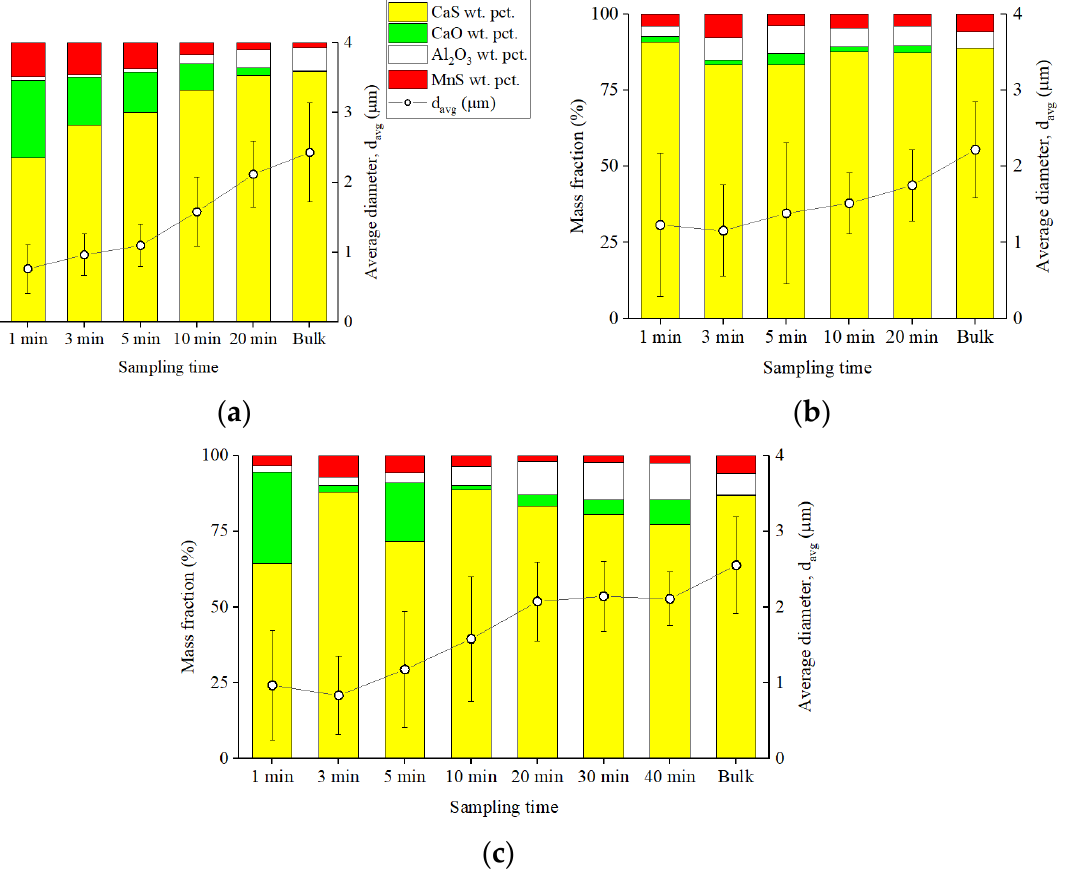
Figure 5. Average diameters and compositions of CaS type inclusions in ( a ) Exp. 2035, ( b ) Exp. 3035, and ( c ) Exp. 2025.